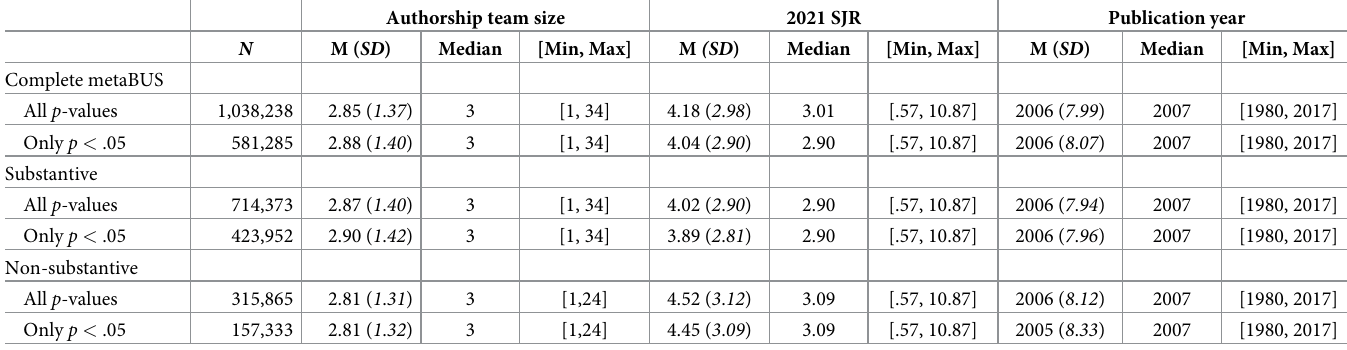
Table 3. Descriptive statistics for data